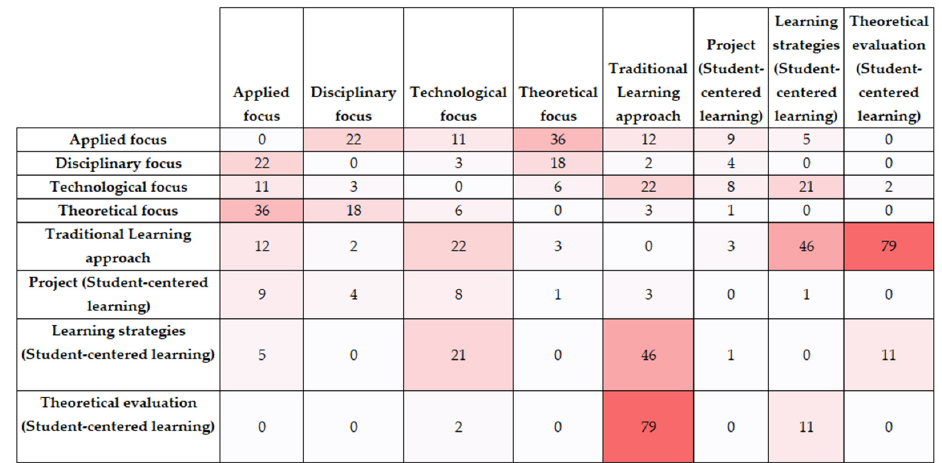
Figure 3. Co-occurrence matrix. Cell ij of this matrix shows the co-occurrence of code i and code j, i.e., the number of times these two codes are linked to the same citation.